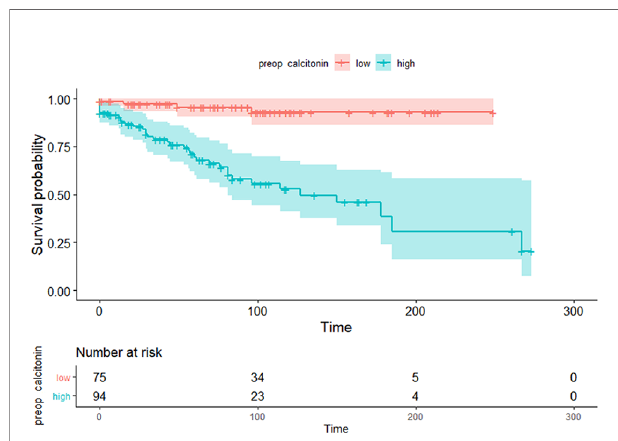
FIGURE 2 | Kaplan – Meier curves of disease-free survival according to the preoperative serum calcitonin cut-off value (309 pg/mL) ( P <